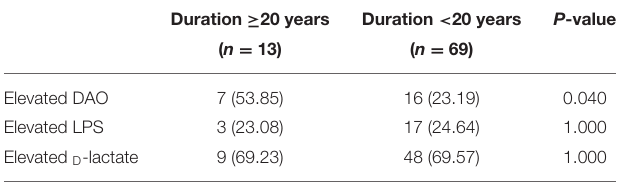
TABLE 3 | Intestinal barrier markers in patients with different durations of